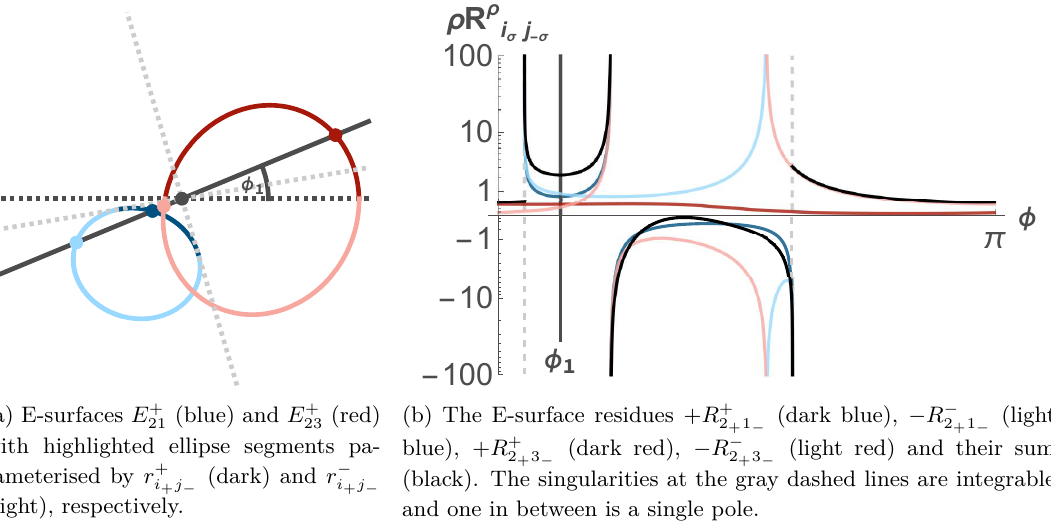
Figure 6. Local (mis)cancellations in the imaginary part of a scalar triangle according to a naive application of eq. (3.32). The E-surfaces E + in two-dimensional spatial momentum space are shown ij in (a) and their corresponding residues ρR ρ in (b). They are parameterised by the radial solutions i + j − . For angles φ ∈ [0 , π ) the E-surfaces are scanned at two points simultaneously. The upper in- r ρ i + j − tersection, where r + = r − , results in the miscancellation between the poles in + R + and − R − . 21 23 2 + 1 − 2 + 3 − This is due to the opposite orientation of the parameterisation of the intersecting ellipse segments (dark blue, light red). The lower intersection however, where r − = r − , corresponds to spurious, 21 23 locally cancelling poles in − R − and − R − . In this case, the intersecting ellipse segments (light 2 + 1 − 2 + 3 − blue, light red) are parameterised with the same (positive) orientation. Another notable feature are the integrable singularities of the residues ± R ± at the tangents (gray) of the ellipse E + 2 + 1 − 21